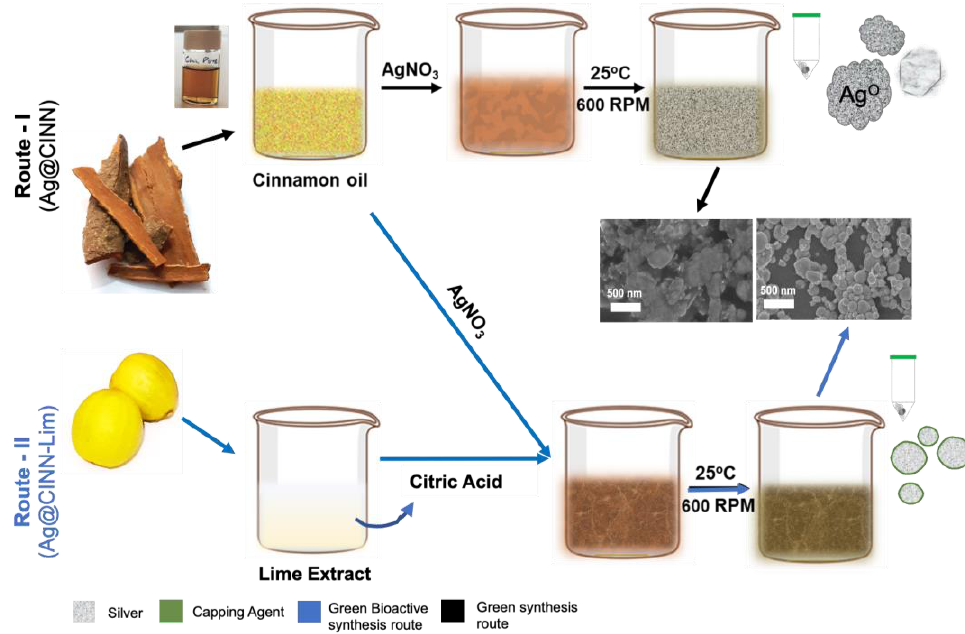
Figure 9. Schematic presentation of green synthesis of bioactive silver nanoparticles .